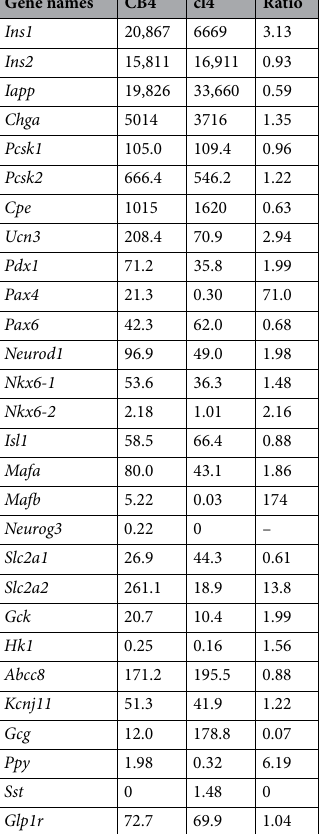
Table 1. Expression levels of β-cell-related genes in MIN6-CB4 and cl4 cells. The FPKM values from RNA sequencing are shown for the genes listed. FPKM: fragments per kilobase of exon per million mapped